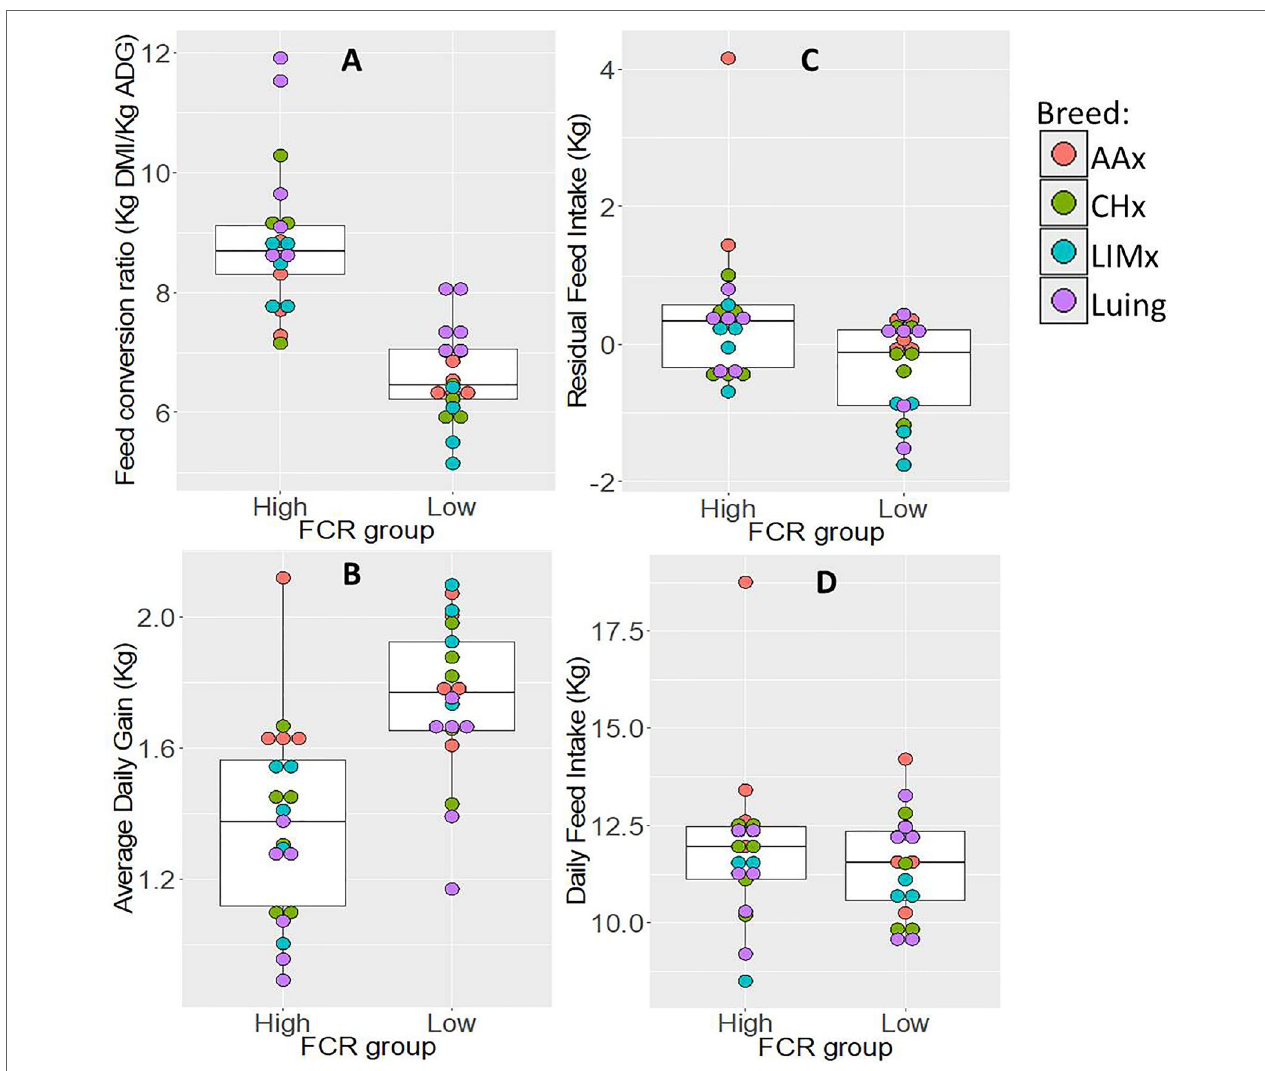
FIGURE 2 | Distribution of variation and range of performance traits: (A) feed conversion ratio, (B) average daily gain, (C) residual feed intake, and (D) daily feed intake within feed conversion ratio groups (high and low). The boxplots show the variation and range of each trait within each feed conversion ratio group. FCR, feed conversion ratio; AAx, crossbred Aberdeen Angus; CHx, crossbred Charolais; LIMx, crossbred